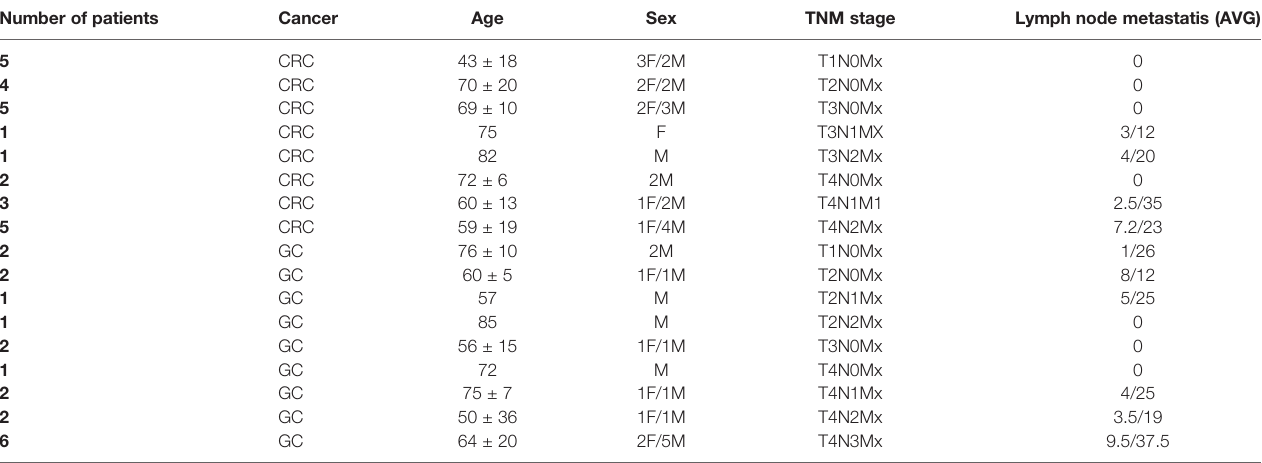
TABLE 1 | Number of patients, cancer type [colorectal cancer (CRC) or gastric cancer (GC)], age, sex, TNM stage, and average of number of metastatic lymph nodes in each enrolled group of patients. Number of